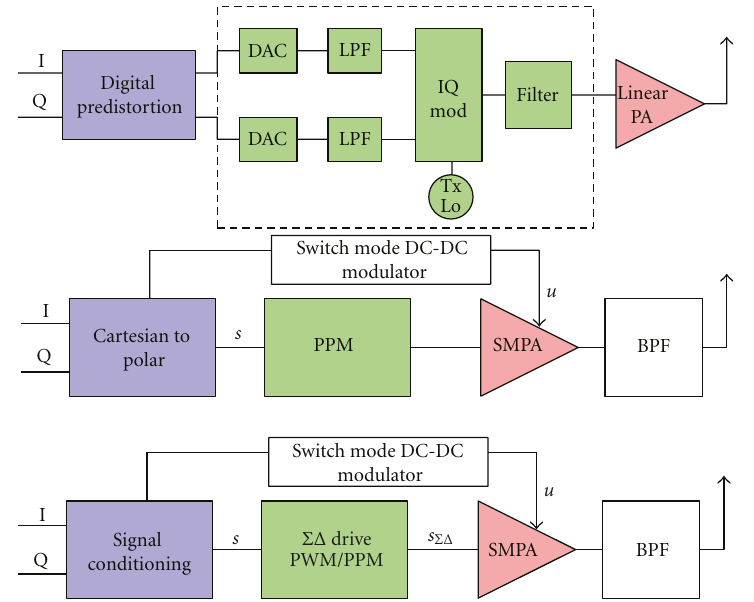
Figure 1: Traditional (top), EER (middle), and proposed (bottom) transmitter architectures.